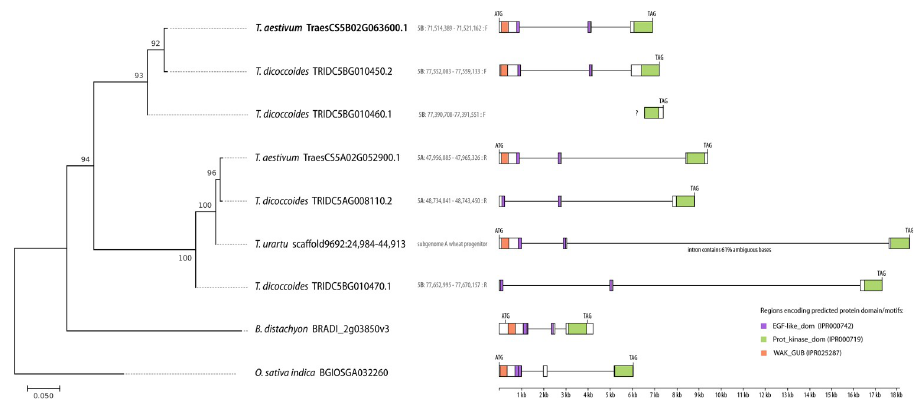
Fig 1. Phylogenic relationships among 8 putative TaWAK6 ( TraesCS5B02G063600 ; KR815340) homologs. WAK6 is present uniquely in commelinids, with the exception of Aegilops tauschii and Hordeum vulgare (based on currently available genomic, transcriptomic and protein sequences). The phylogeny was reconstructed based on the amino acid sequence of kinase domains using the maximum likelihood method. The percentages of replicate trees in which the associated taxa clustered together in the bootstrap test (1000 replicates) are shown next to the branches. The tree was rooted with the sequences of two outgroup species: Oryza sativa and Brachypodium distachyon .